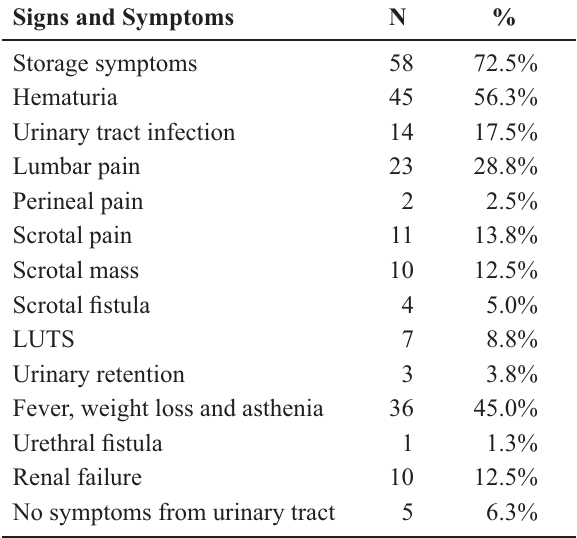
Table 1 – Presenting signs and symptoms in 80 patients with urogenital tuberculosis.